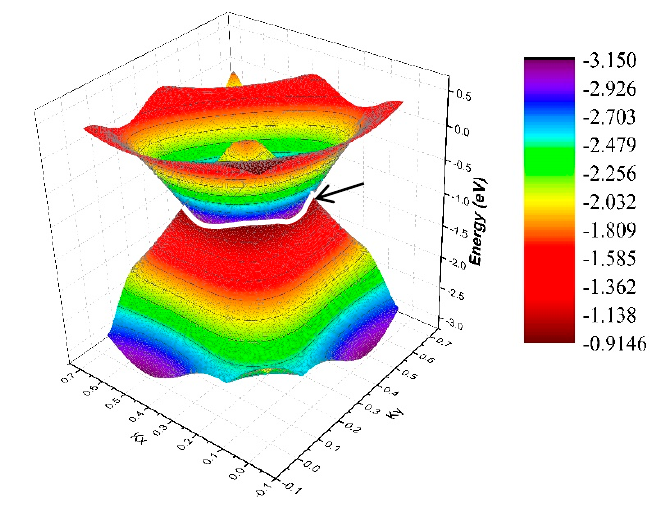
Figure 5. 3D band dispersion around the K point in the k z = 0 plane. The white line shows the profile of the nodal line.